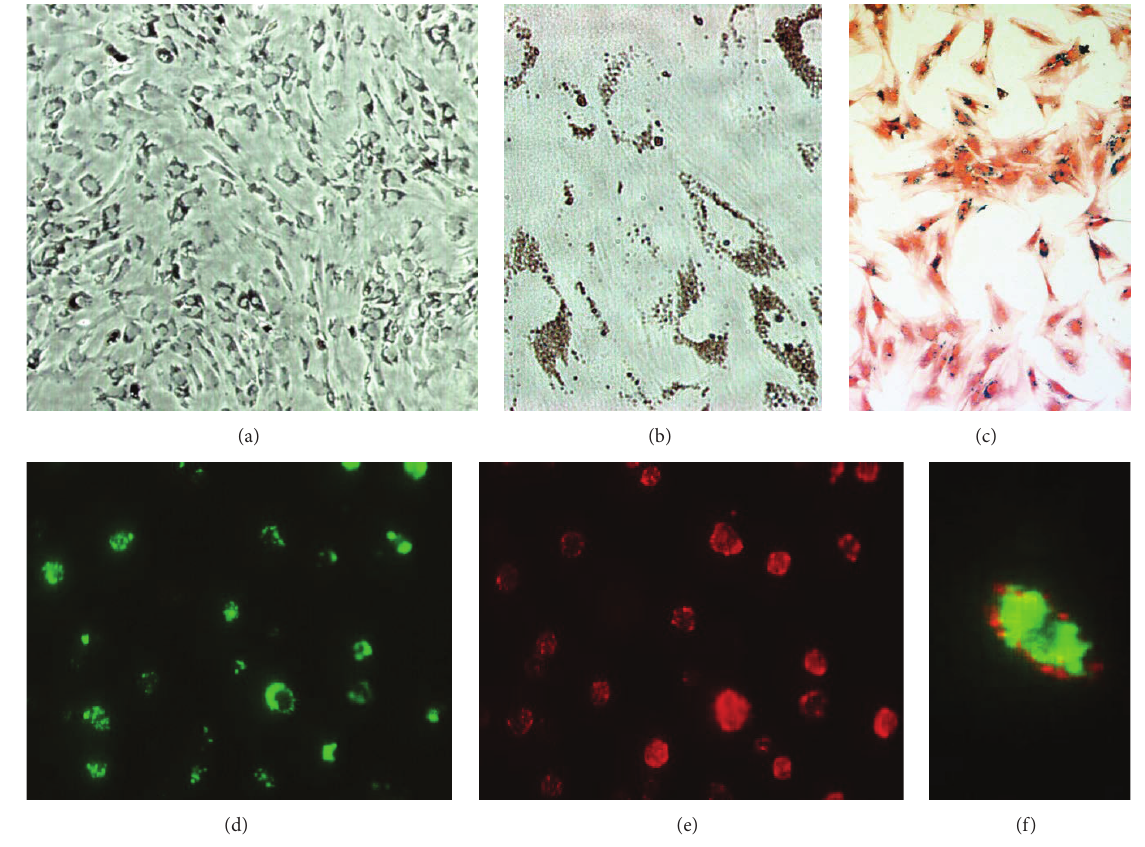
Figure1:Dual-labeledmesenchymalstemcells(MSCs).(a)Phasecontrastimagesshowedalmost99%ofthecellslabeledwithMPIO(original magnification × 100). (b) The iron particles gathered in the cytoplasm and perinuclear area (original magnification × 400). (c) Iron staining demonstrated high MPIO labeling efficiency ( > 98%) represented as numerous blue granules in the cytoplasm (original magnification × 100). (d)–(f) The green fluorescence of the MPIOs was clearly detected in the cytoplasm (d and f) and the red CM-DiI in the membrane of MSCs (e and f), original magnification ×